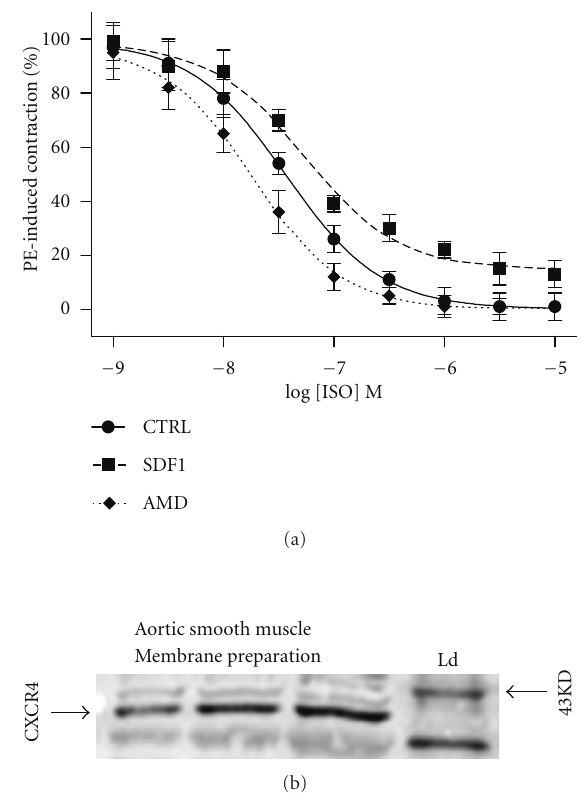
Figure 1: Vascular smooth muscle and chemokine receptor subtype 4 (CXCR4). (a) Aortae from 2-month-old animals ( n = 5) were isolated and mounted on an apparatus to measure vascular reac- tivity as described [12]. Vessels were exposed to three